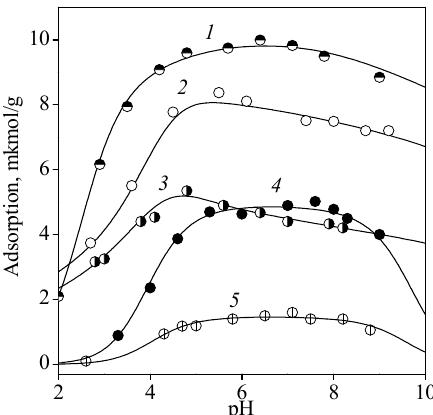
Figure 3. Adsorption of guanosine ( 1 ), cytidine ( 2 ), adenosine ( 3 ), 2 ′ -deoxycytidine ( 4 ), and 2 ′ -deoxyadenine ( 5 ) from 0.01 M NaCl solution onto titanium dioxide surface: C TiO2 = 5 g/L, and C nucleosine = 0.1 mmol/L.